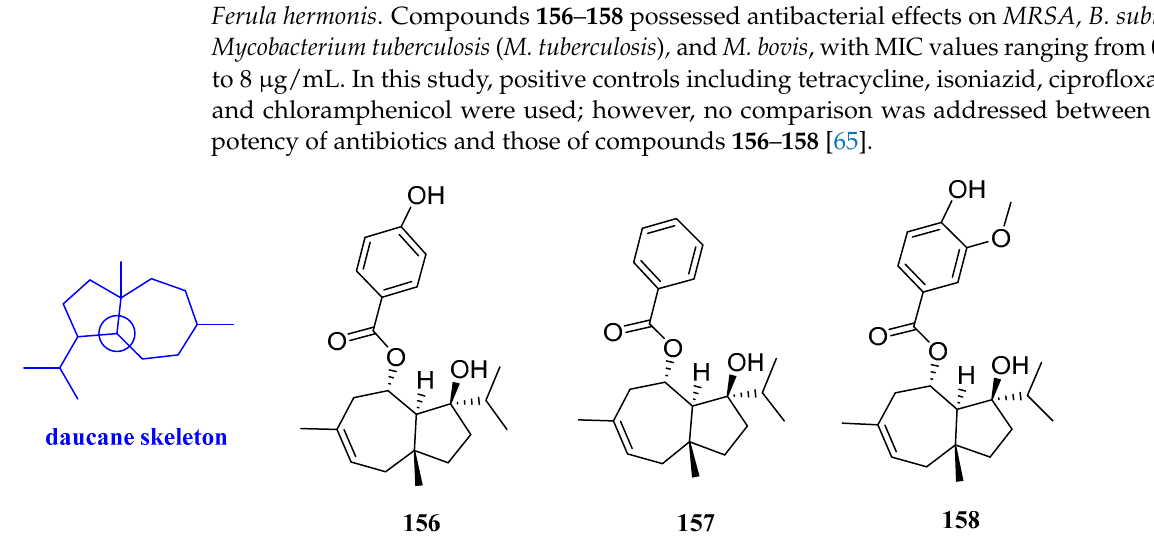
Figure 16. Structures of cuparane - type sesquiterpenoids 153 ‒ 155 .